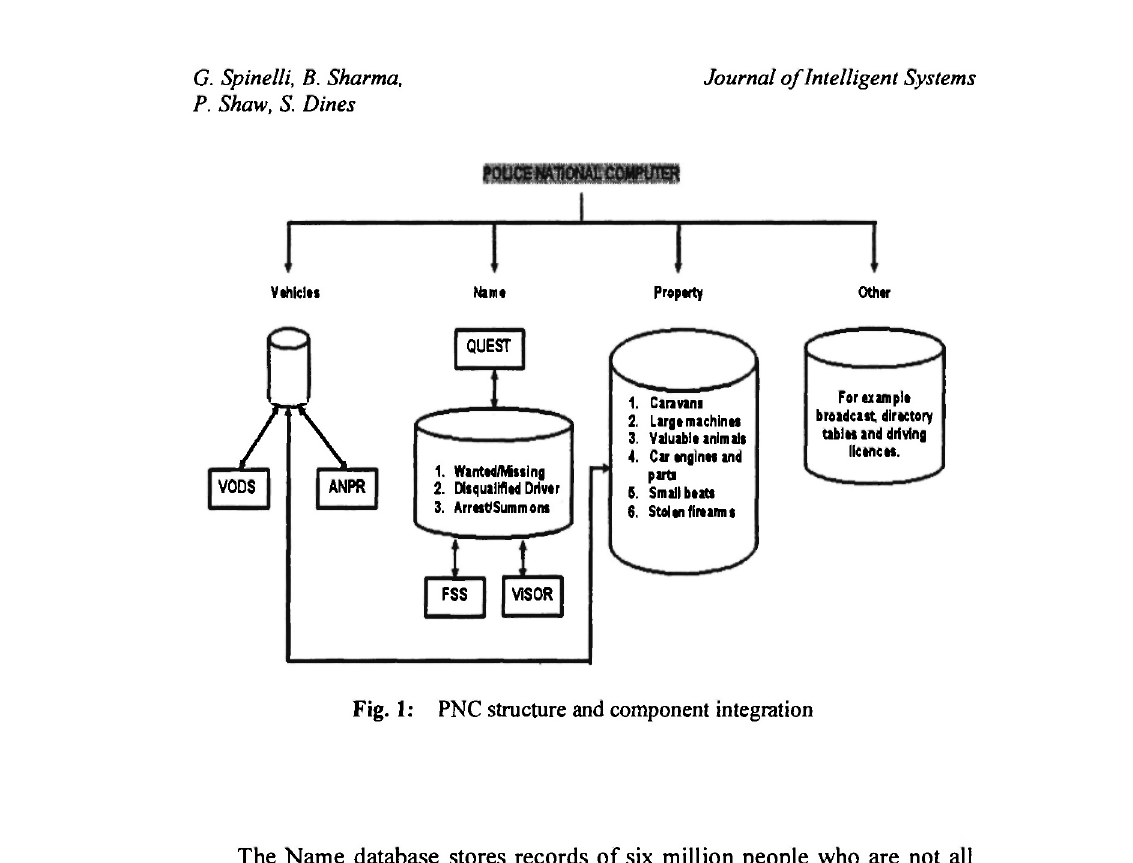
Fig. 1: PNC structure and component